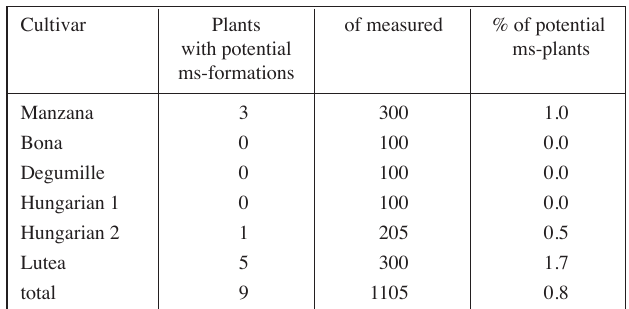
Tab. 2: Detected percentages of plants with flower head aberrations in- dicating tendencies to male sterility in the parental generation of six